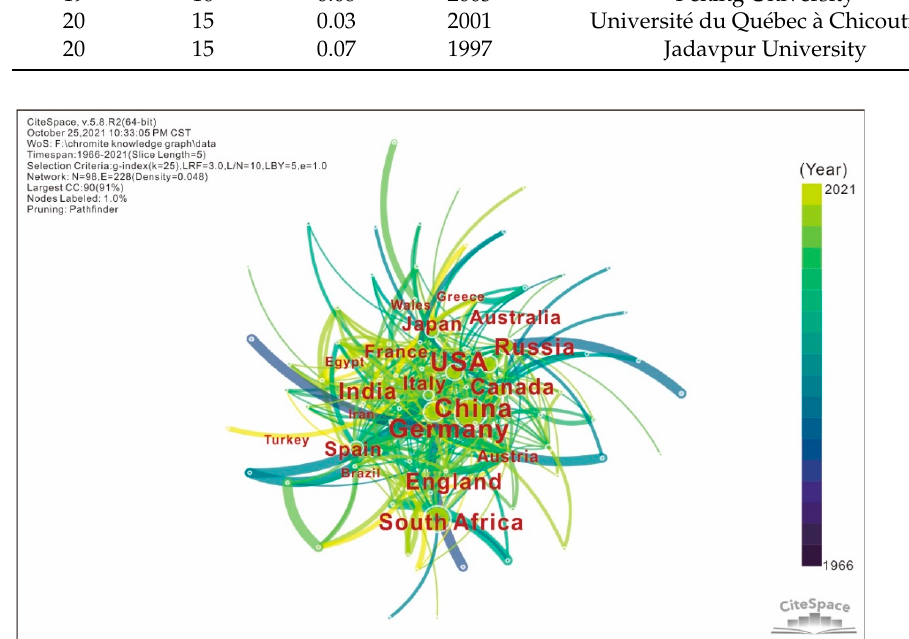
Figure 4. Co-occurring countries map. Table 3. Top 20 countries ranked by the number of publications with a focus on chromitite.